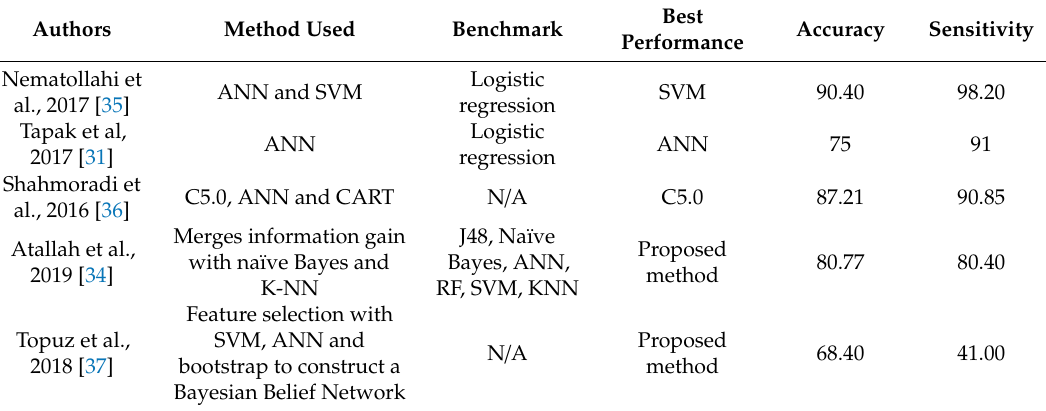
Table 2. Classification of patient survival.